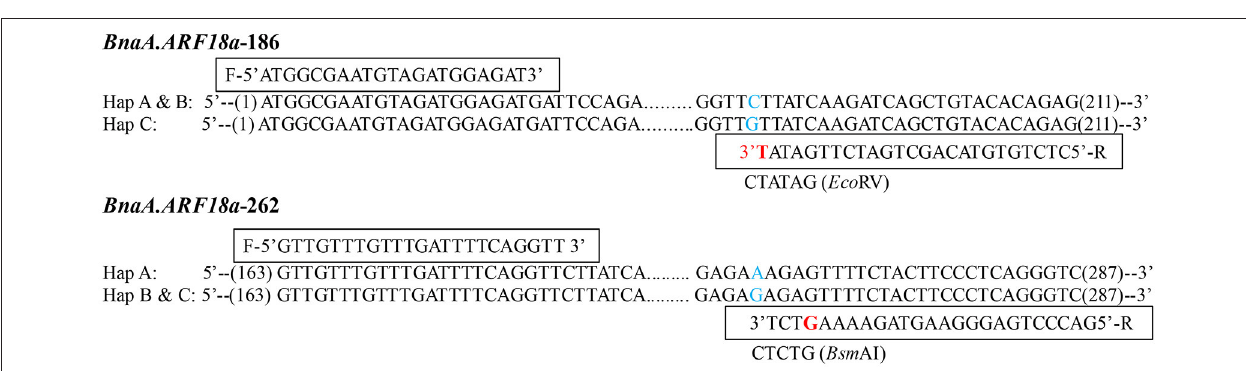
FIGURE 5 | Development of two dCAPS markers in BnaA.ARF18a , BnaA.ARF18a -186 ( Top ) and BnaA.ARF18a -262 ( Bottom ). The primers and the restriction enzymes were displayed in the box. The blue letter represents the SNP among haplotypes, while the red letter represents the transversion in the restriction